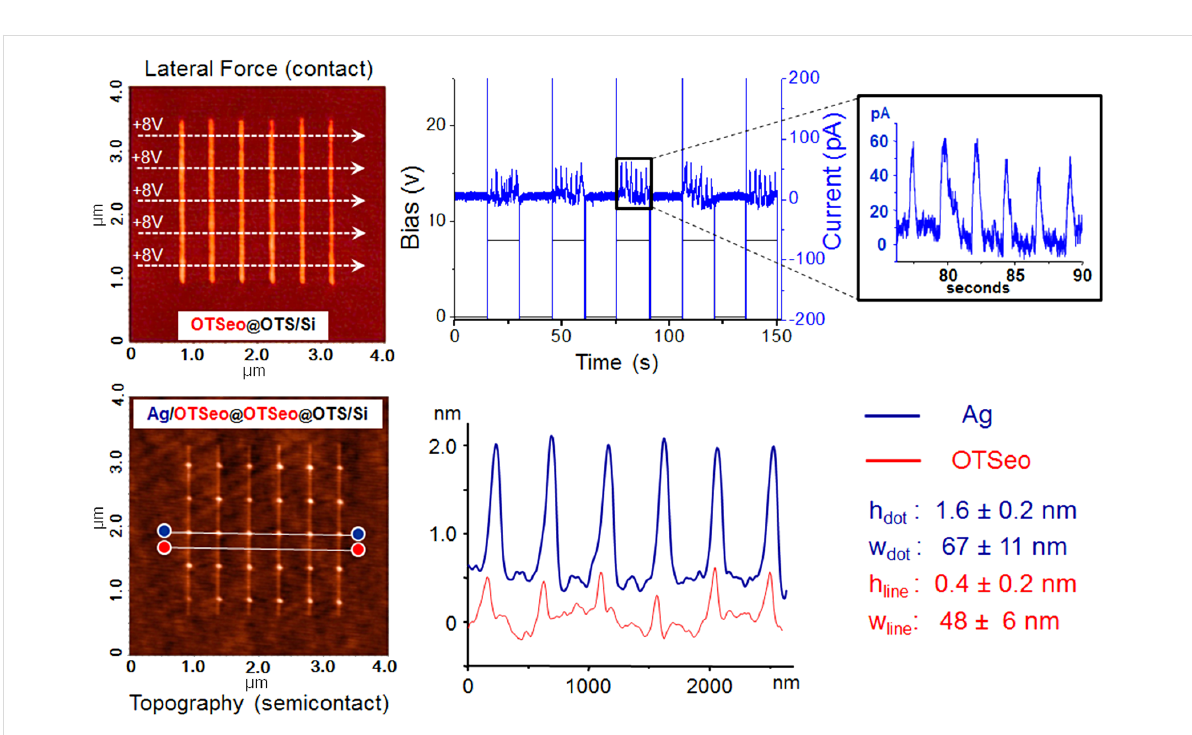
Figure 5: Fabrication of a rectangular array of 30 silver/monolayer nanodots by the serial CET process outlined in Figure 4 (see Experimental section): (Top row, left) five horizontal tip excursions across the array of six parallel OTSeo lines used in the assembly of the Ag/OTSeo nanodots (indicated by white arrows in the lateral force SFM image of the OTSeo lines); (top row, right) plots of tip bias voltage (+8 V, black curve) and corres- ponding current (blue curve) versus time recorded during each tip excursion (tip moving in contact with the surface at a constant speed of 250 nm/s); (bottom row) topographic semicontact-mode SFM image of the resulting dots@lines pattern (Ag/OTSeo@OTSeo@OTS/Si) and distance–height profiles along the middle row of Ag/OTSeo dots (blue curve, shifted vertically for clarity) and a closely located row of silver-free OTSeo crossing points (red curve). The average heights and widths listed on the right refer to all 30 dots and OTSeo crossing points. Contact-mode topographic images of this dots@lines pattern and a comparative analysis of the contact- and semicontact-mode topographic images (revealing the artifactual nature of the former) are provided in the Supporting Information File 1 (Figures S2 and